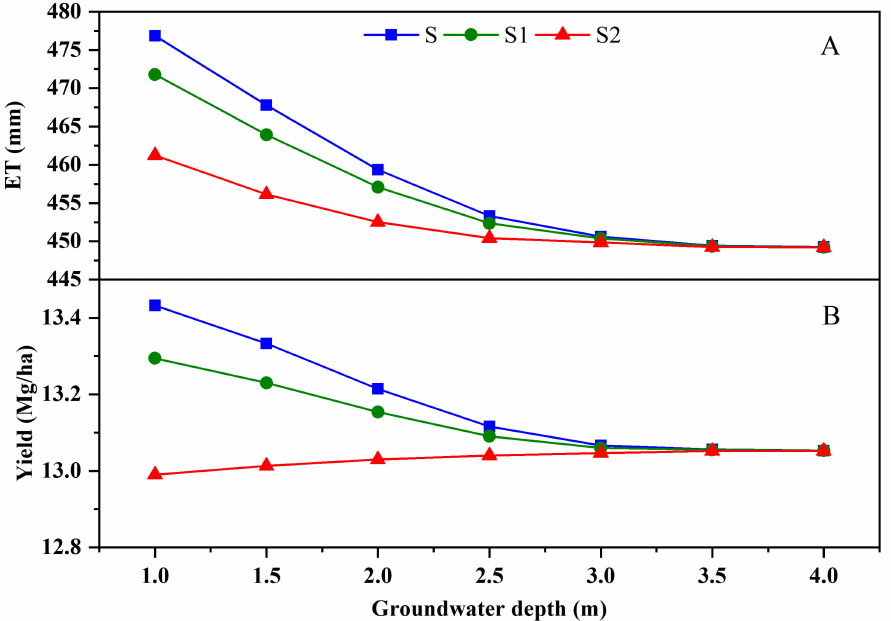
Figure 5. Actual crop evapotranspiration of maize and yield during the growing period under various groundwater depths and groundwater salinity. ( A ) Actual crop evapotranspiration of maize during the growing period with groundwater depth ranging from 1 m to 4 m and groundwater salinity ranging from 1 g / L to 4 g / L. ( B ) Crop yield during the growing period with groundwater depth ranging from 1 m to 4 m and groundwater salinity ranging from 1 g / L to 4 g / L. Note: ET is actual crop evapotranspiration. S, S1 and S2 refer to the scenarios with groundwater salinity of 1 g / L, 2 g / L and 4 g / L,